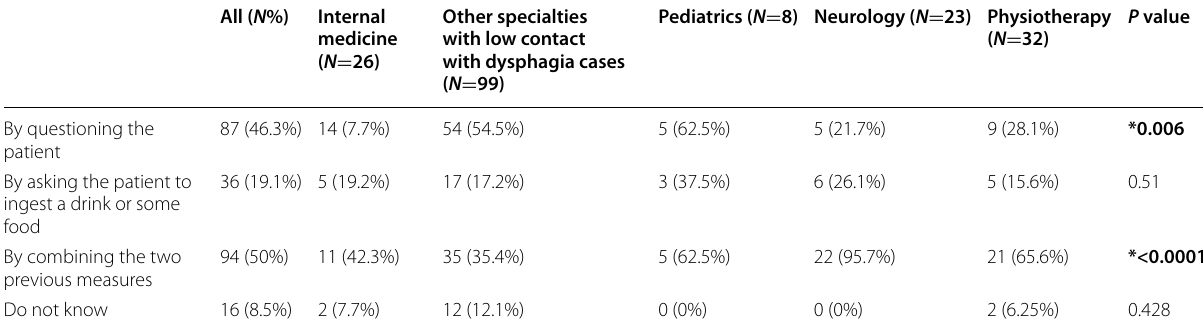
Table 2 Percentages and comparison among participants in different specialties regarding their responses about the identification of dysphagia